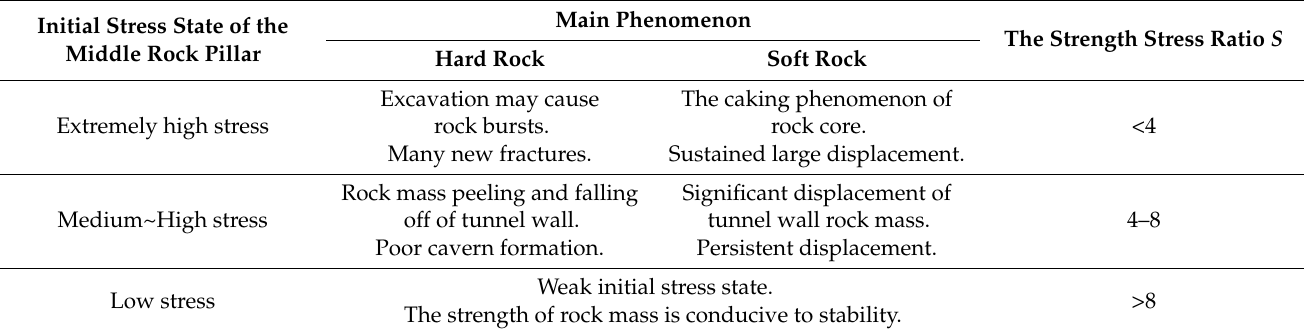
Table 5. Classification of the initial stress state of the middle rock